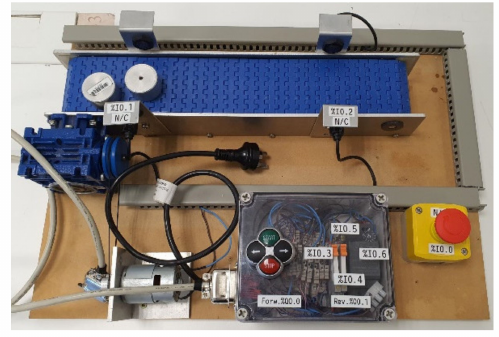
Figure 3. Experiment 1 forward/reverse conveyor